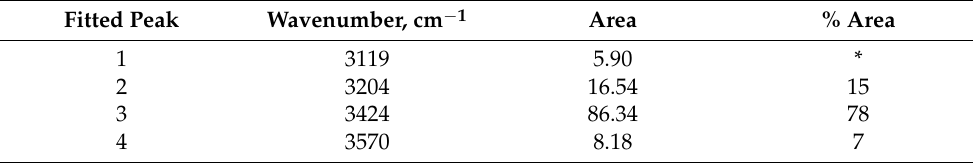
Table 3. Wavenumber, areas and percentage areas of the fitted peaks presented in Figure